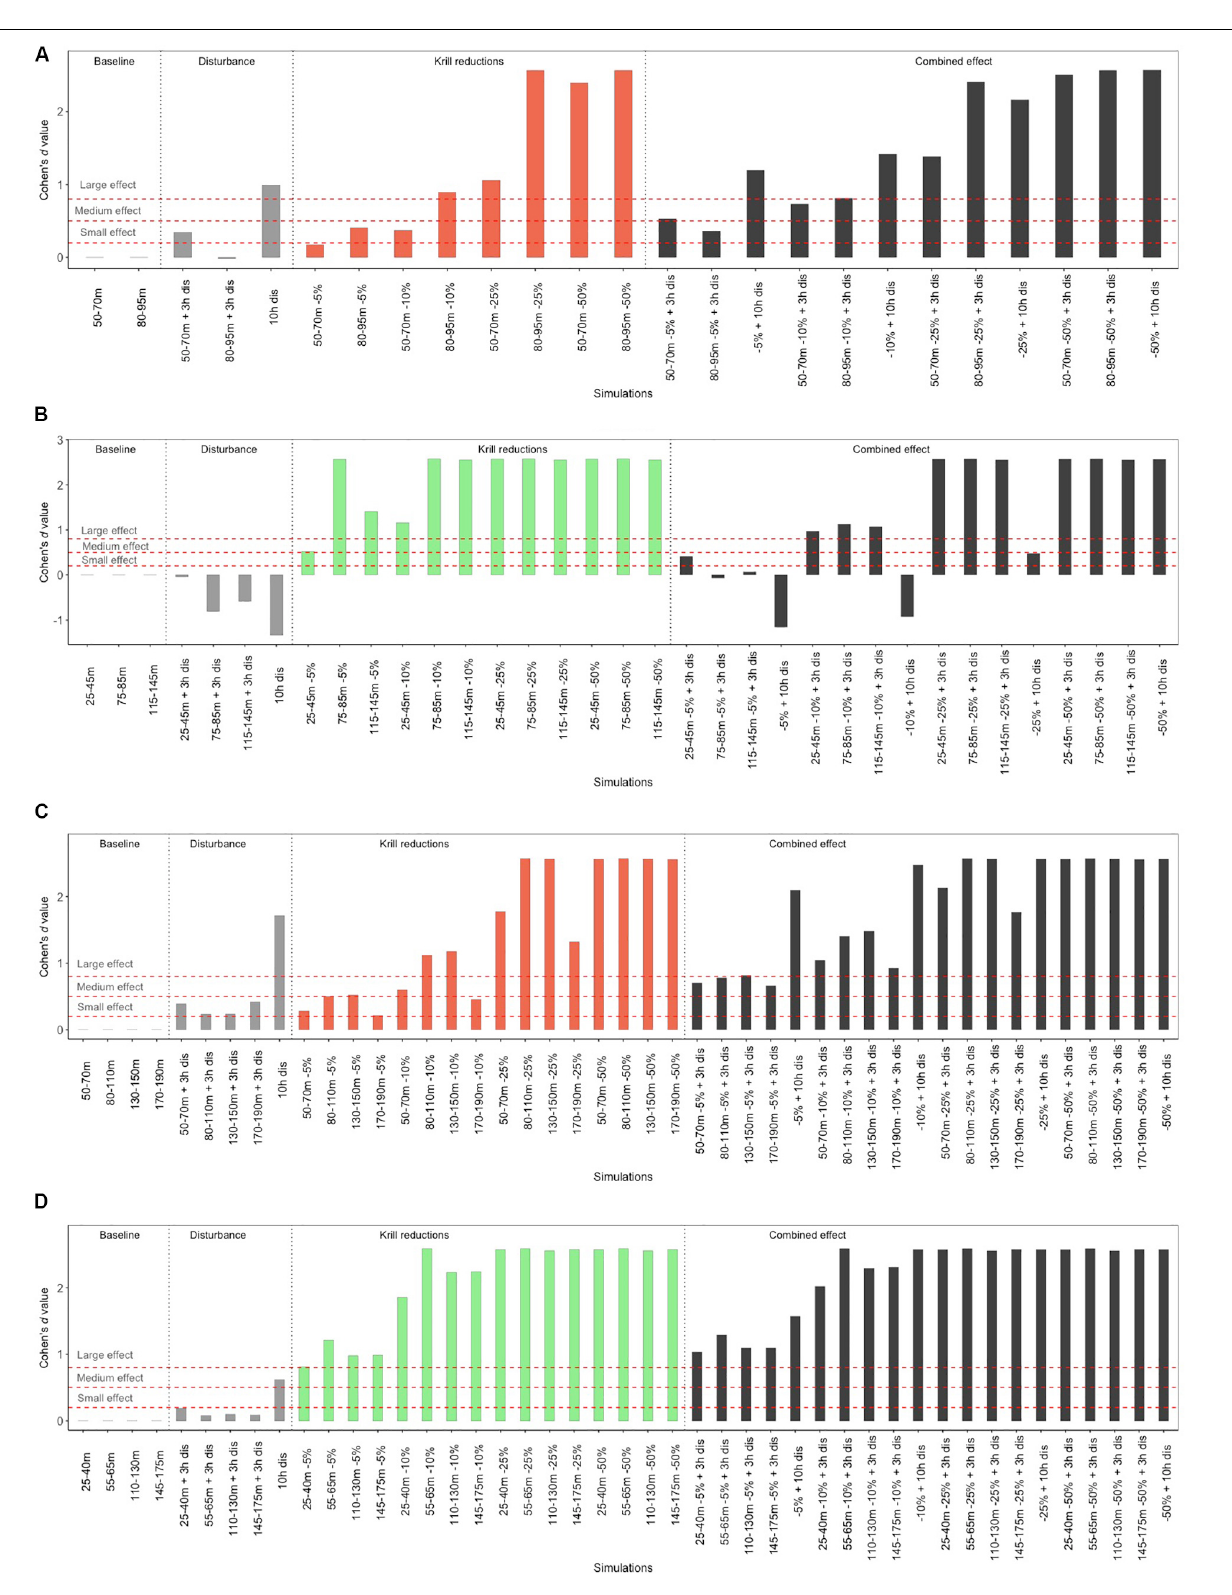
Frontiers in Marine Science |